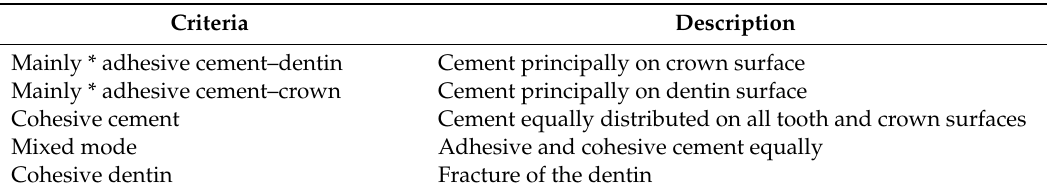
Table 1. Classification of failure criteria.